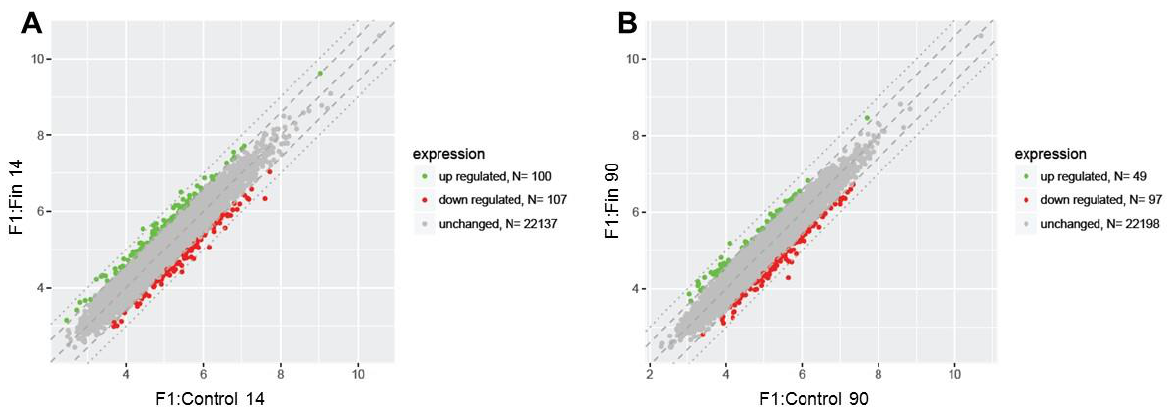
Figure 1. Scatter plots illustrating differentially expressed genes (DEGs) in the four experimental comparison groups: F1:Fin 14 vs. F1:Control 14 ( A ), F1:Fin 90 vs. F1:Control 90 ( B ). Each dot represents a single gene. The selection criteria for significantly changed gene expression were based on a greater than 1.5-fold difference in expression.